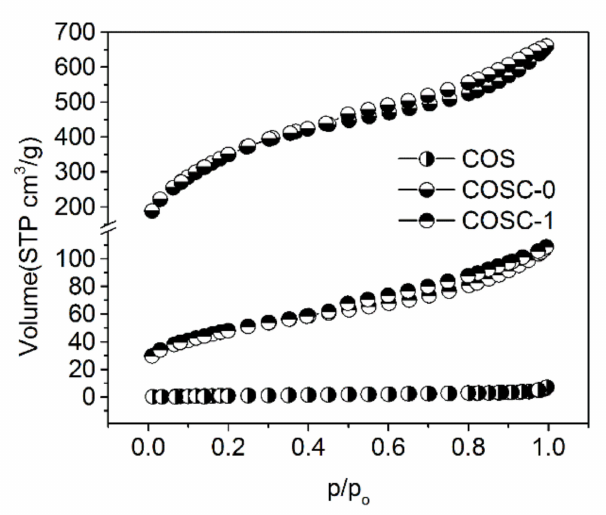
Figure 5. Nitrogen adsorption–desorption isotherm of COS, COSC-0, and